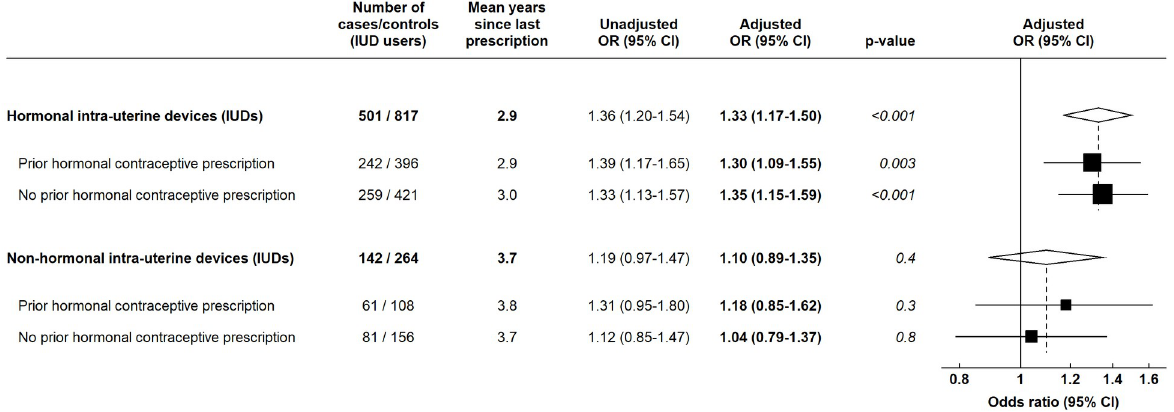
Fig 4. ORs and 95% CIs for breast cancer in women last prescribed an IUD versus women with no contraceptive prescriptions. Data from the CPRD. All ORs are versus women with no recorded prescriptions for either a hormonal contraceptive or nonhormonal IUD during the observation period. Numbers may vary from previous analyses as women whose last contraceptive prescription was for a nonhormonal IUD are considered under this category, even if they had previously received a hormonal contraceptive prescription. Adjusted ORs are adjusted for time since last birth, number of recorded births, BMI, and alcohol intake. P values are based on the relevant Wald tests. BMI, body mass index; CI, confidence interval; CPRD, Clinical Practice Research Datalink; IUD, intrauterine device; OR, odds